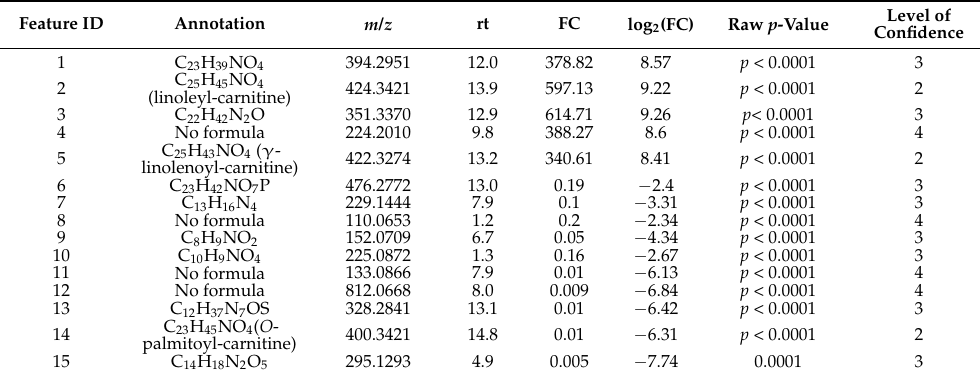
Figure 4. The impact of tomato root colonization by Trichoderma harzianum on the gut metabolome of Manduca sexta larvae. ( A ) Two-dimensional principal component analysis (PCA) scores plot of M. sexta gut samples. ( B ) Significant metabolomic features annotated for the M. sexta gut samples. Manduca sexta larvae were fed for three weeks on leaves of tomato plants that were non-inoculated or root inoculated with T. harzianum . In ( B ), the volcano plot displays fold change threshold ( x -axis) of 2 and t -test threshold ( y -axis) of 0.05. The purple circles represent features above the threshold. Both fold changes and p -values are log-transformed. The metabolomic features that showed the highest increase for the larvae reared on non-inoculated plants are found towards the right side of the volcano plot. The metabolomic features that showed the highest increase for the larvae reared on T. harzianum -inoculated plants are found towards the left side of the volcano plot. The most statistically significant metabolomic features for both treatments are found towards the top of the volcano plot. Table 3. The most significant metabolomic features annotated for the gut samples of Manduca sexta larvae fed for three weeks on leaves of tomato plants that were non-inoculated and root-inoculated with Trichoderma harzianum. The feature number corresponds to the features given in Figure 4B and are given by their corresponding mass to charge ratio ( m / z ) and retention time (rt) in minutes. The fold change (FC) refers to the feature’s qToF intensity and was calculated on the basis of a volcano plot conducted for the non-inoculated and T. harzianum-inoculated larvae. The volcano plot was conducted with a fold change threshold ( x -axis) of 2 and t -test threshold ( y -axis) of 0.05. The level of confidence of the identicication/annotation is given according to Malinowska and Viant